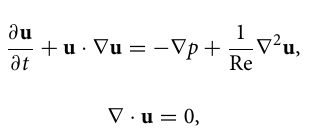
Figure 6. Space-time solutions of (a) mid-pulse wave-splitting in 1D two-component Gray-Scott model obtained using semi-implicit variational quantum reaction-diffusion solver on 2 6 600 , for chemical species u 1 (left) and u 2 (right). Parameters include D T = 0.5 . (b) Traveling wave solutions for 1D Brusselator model on 2 4 0.02 and dt k 2 = = 400 on Neumann boundary conditions. Parameters include D to T = 0.5 dt =